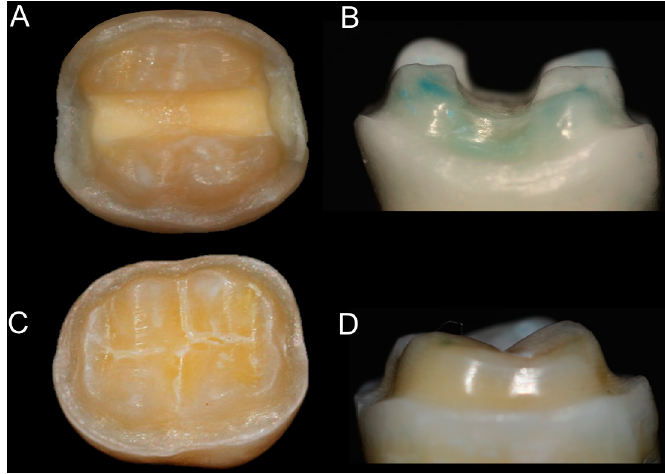
Figure 1- Cavity preparation with occlusal and proximal boxes. (A, B) Cavity with boxes; (C, D) Cavity without